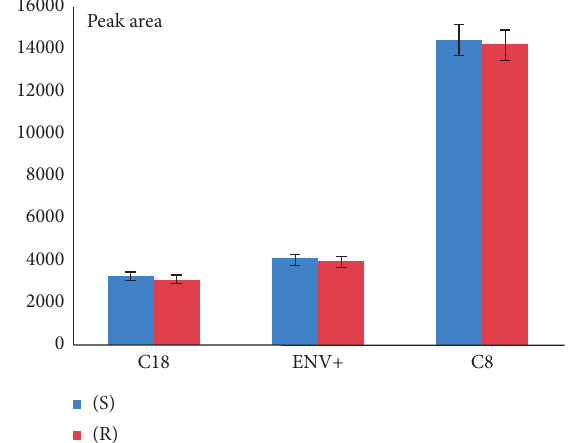
Figure 1: Effect of sorbent type on extraction efficiency (sample conc. 0.01 µ g ·